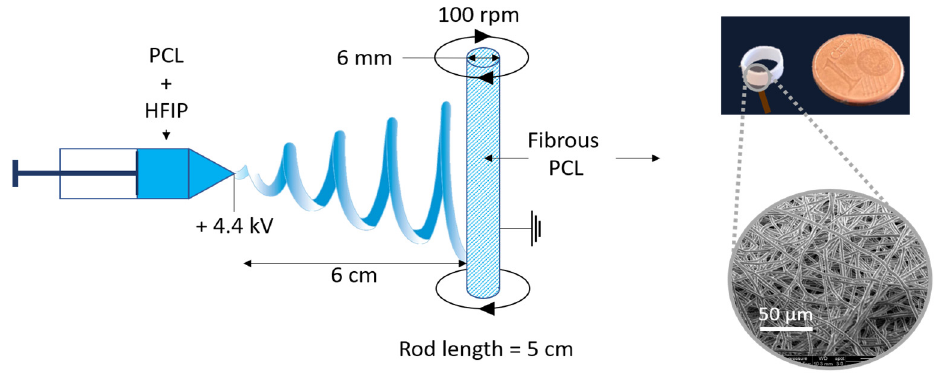
Figure 1. Schematic of the electrospinning set up and illustration of the obtained